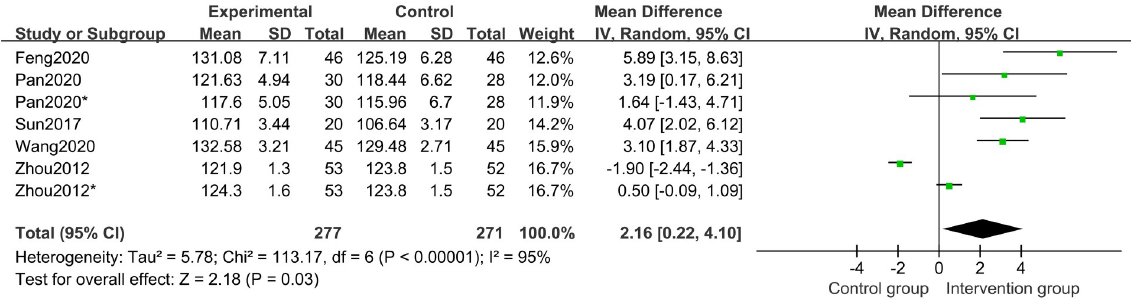
Fig 3. Forest plot showing the effects of CHM in increasing height.